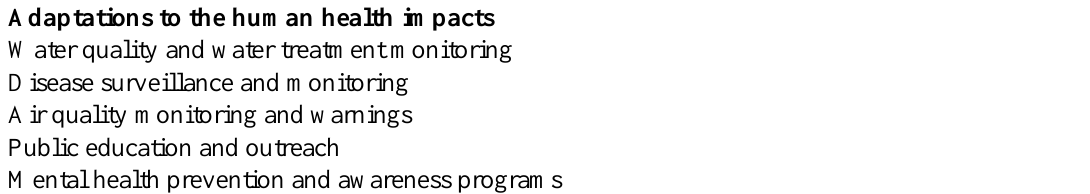
Table 2. Examples of adaptations to reduce the health impacts of